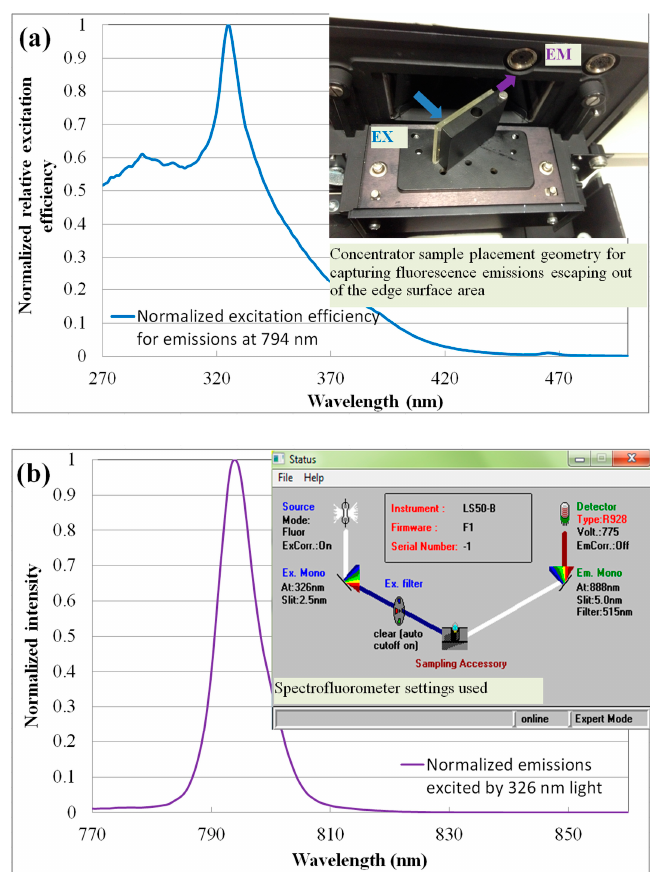
Figure 4. Measurements of the excitation ( a ) and emission ( b ) spectra of epoxy-based lamination interlayers containing suspended particles of ZnS:(Ag, Tm) luminophore. A Perkin-Elmer LS-50B luminescence spectrometer was used to collect and analyze the optical radiation flux propagating out of an edge area of 50 × 50 × 3 mm 3 concentrator samples.